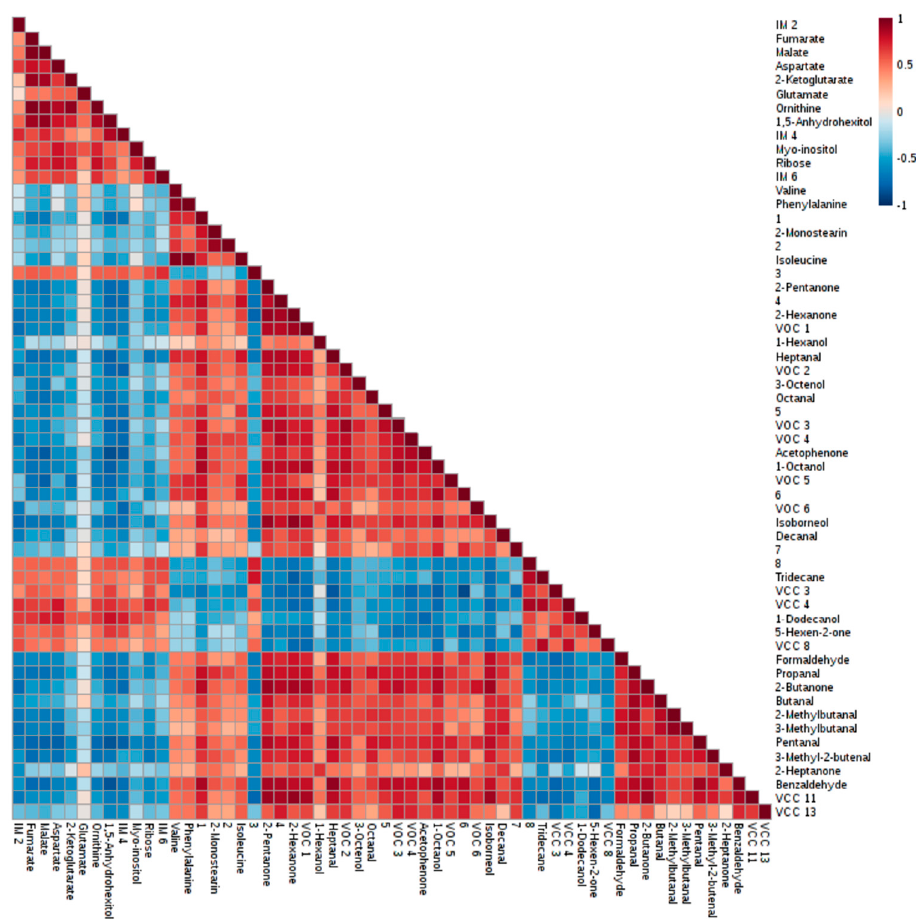
Figure 5. Heatmap representing the Spearman’s correlations between the metabolites significantly altered ( p < 0.01) after a thermal insult. 1. Docosahexaenoic acid; 2. Glycerol monostearate; 3. 1,1-Dimethylpropyl acetate; 4. 4-Methyl-2-pentanone; 5. 3-Ethyl-4-methylpentanol; 6. 2,4,6-Trimethyldecane; 7. 1-(2,4,6-Trimethylphenyl)ethanone; 8. 2,7,10-Trimethyldodecane.